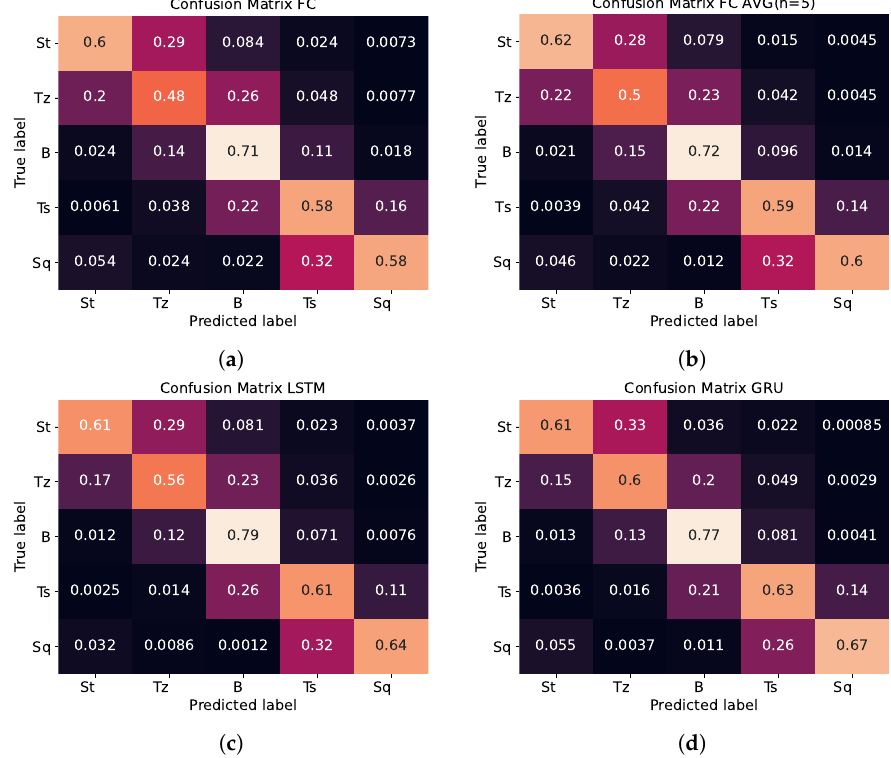
Figure 4. Confusion matrices display the average percentage that a True Label is predicted as a specific class. These values are normalized for the patient cases. ( a ) Fully Connected classifier, ( b ) Fully connected Averaged(n = 5), ( c ) Long Short-Term Memory classifier, and ( d ) Gated Recurrent Unit